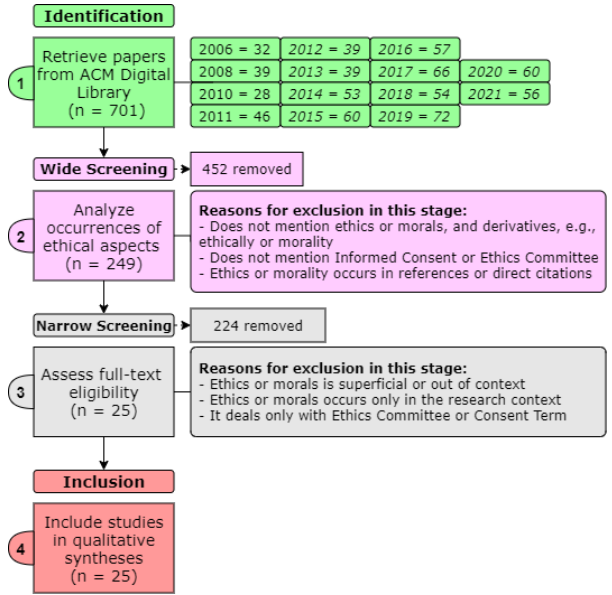
Figure 1. Diagram of the literature review